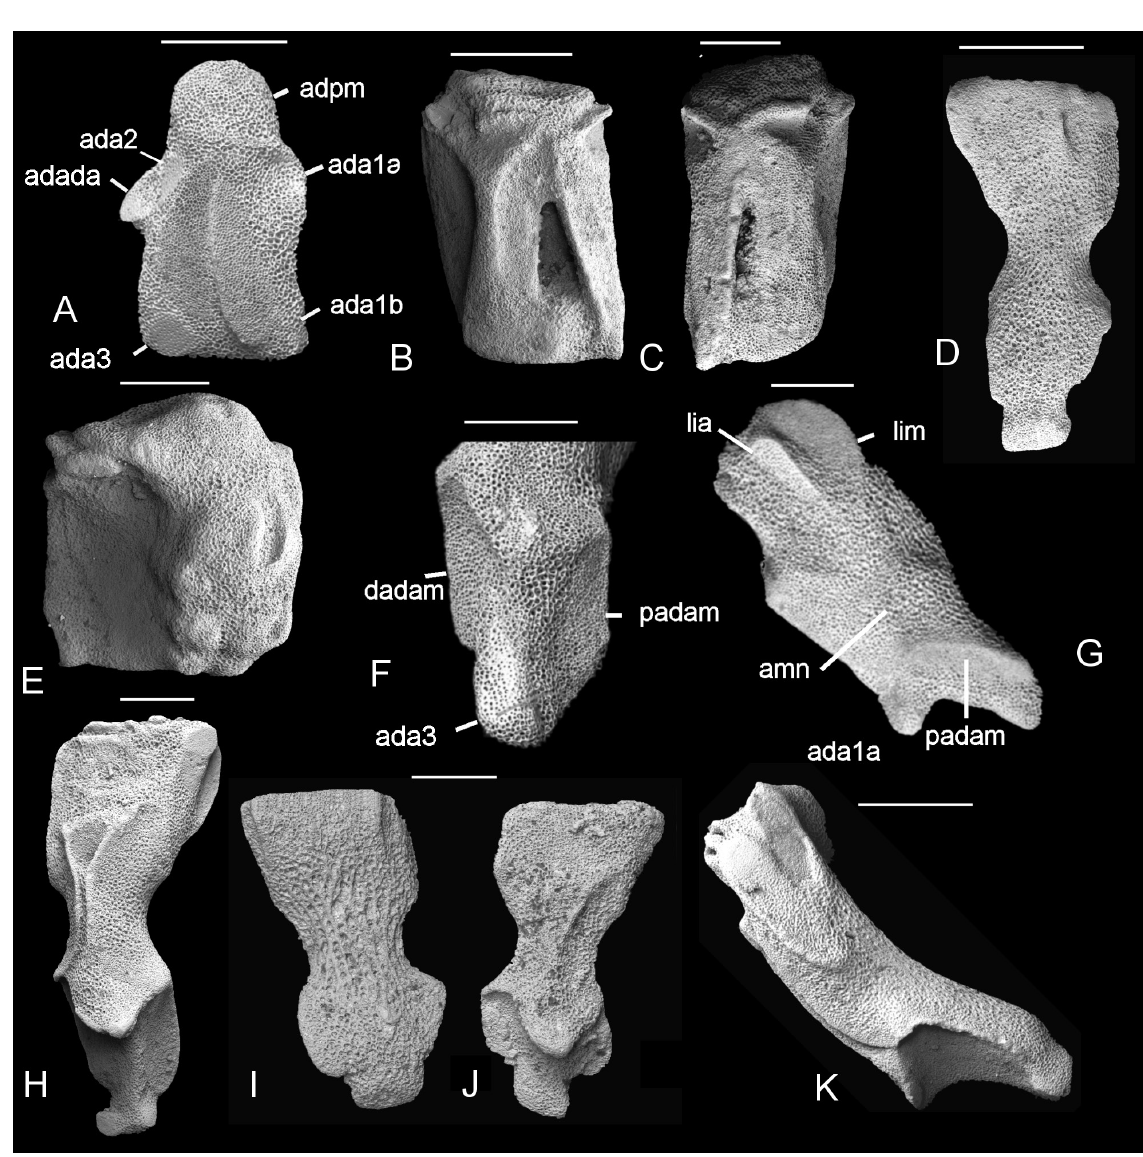
Fig. 17. A, F–G . Zoroaster fulgens Thomson, 1873 (A.S. Gale collection, unregistered). A . Adambulacral, in abactinal view; the original of Gale (2011a: pl. 8 fig. 5). F . Ambulacral base, in actinal view;